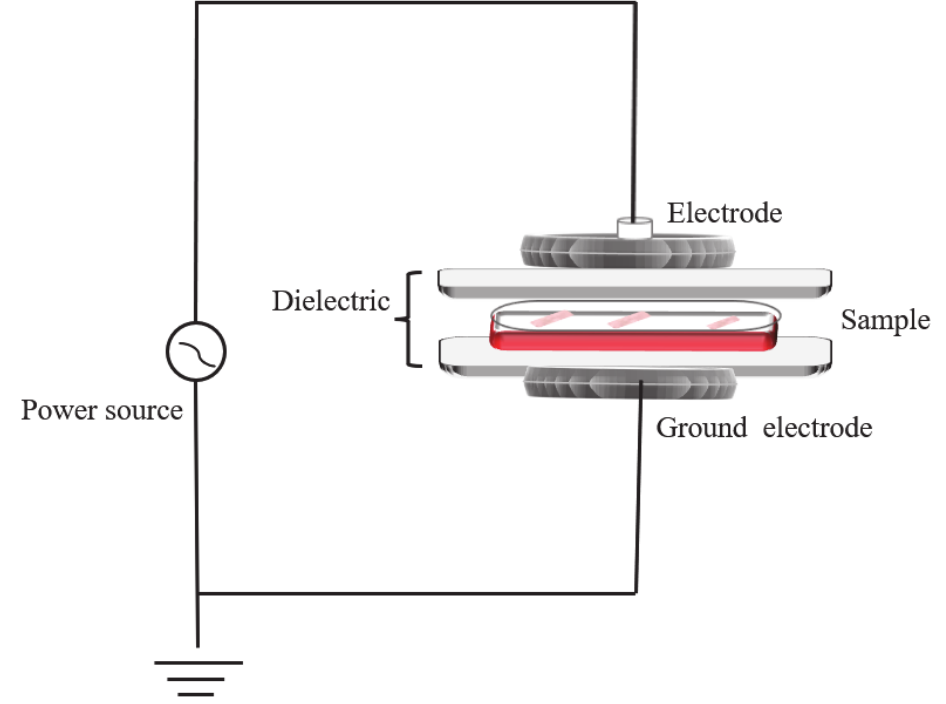
Figure 1. Schematic diagram of high voltage atmospheric cold plasma system.